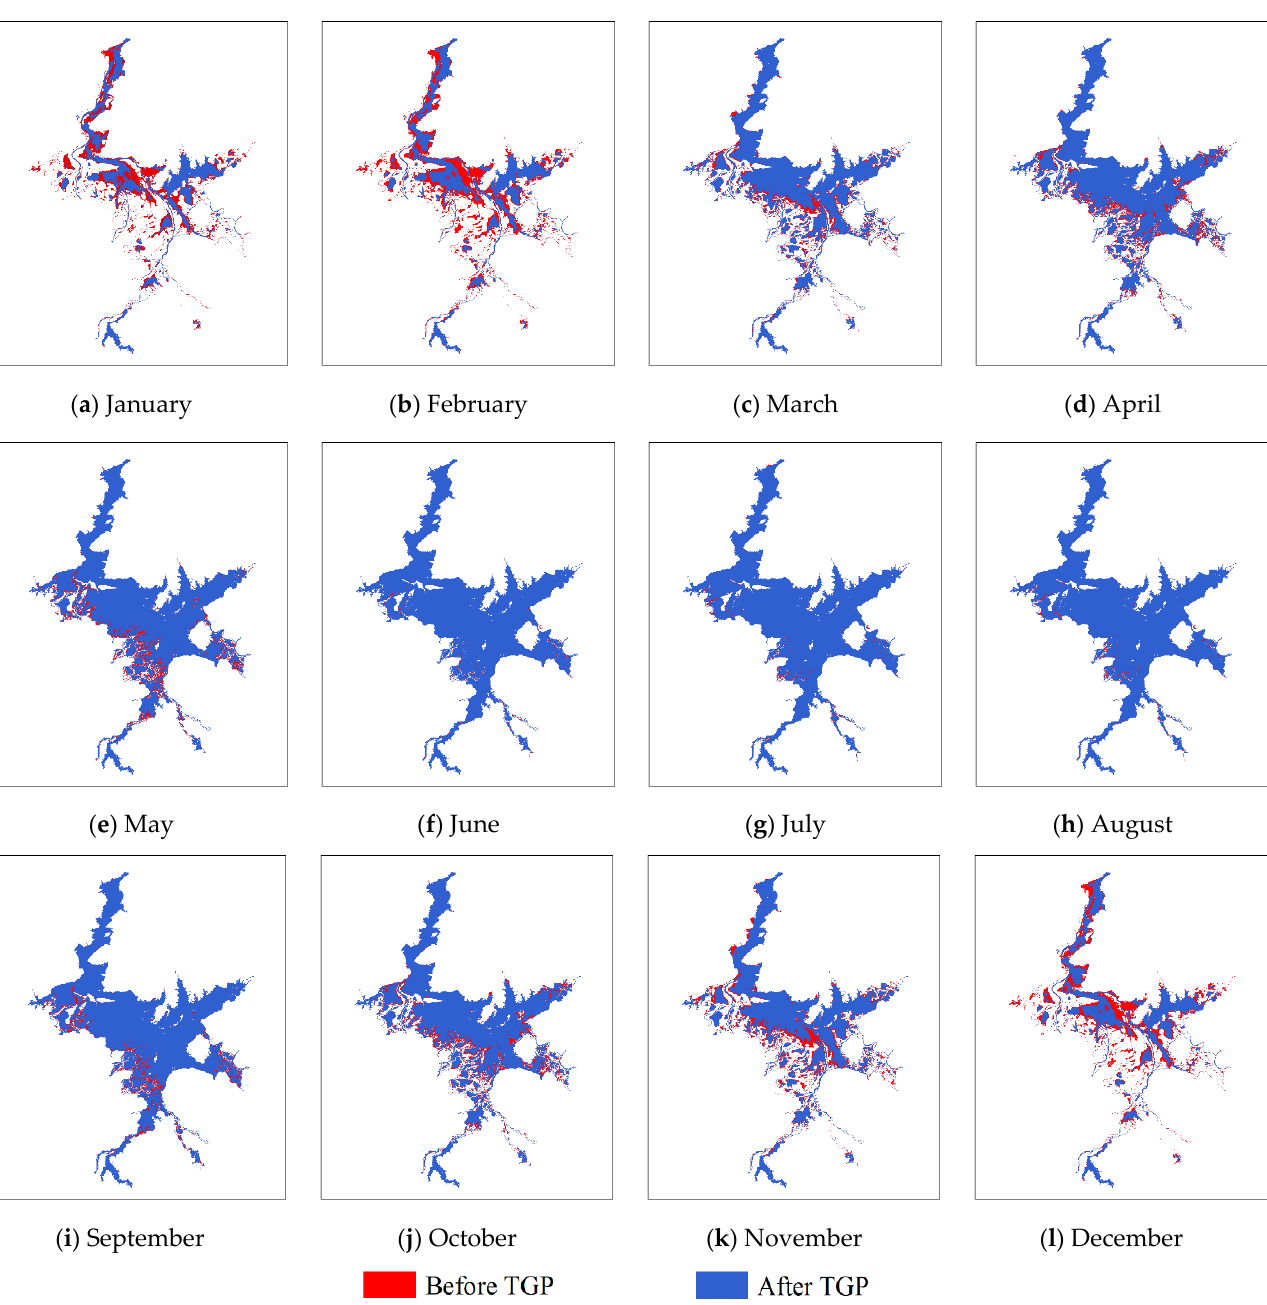
Figure 12. The inter- annual variations of Poyang Lake’s water volume from 1993 to 2020 : the blue line is the water volume, and the black dotted line is the linear regression line.